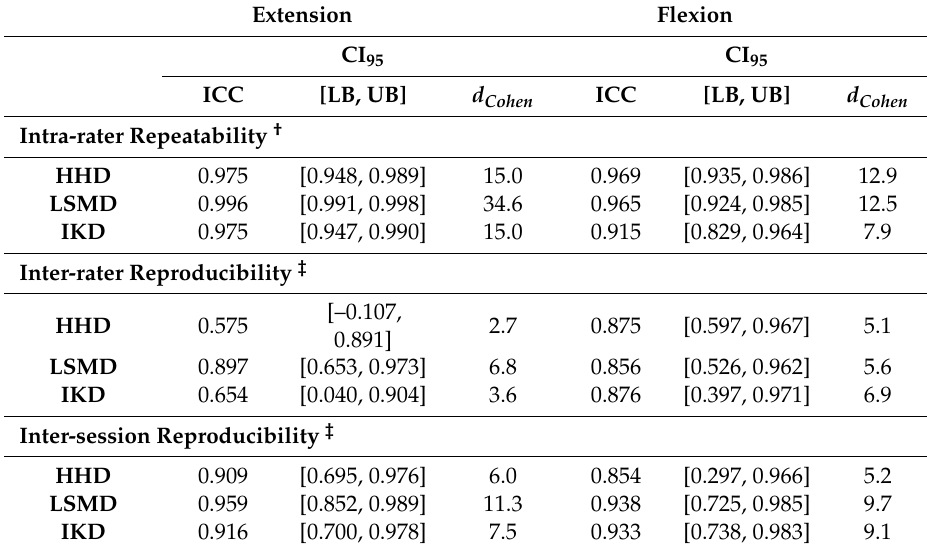
Reliability results for intra-rater repeatability, inter-rater reproducibility and inter-session